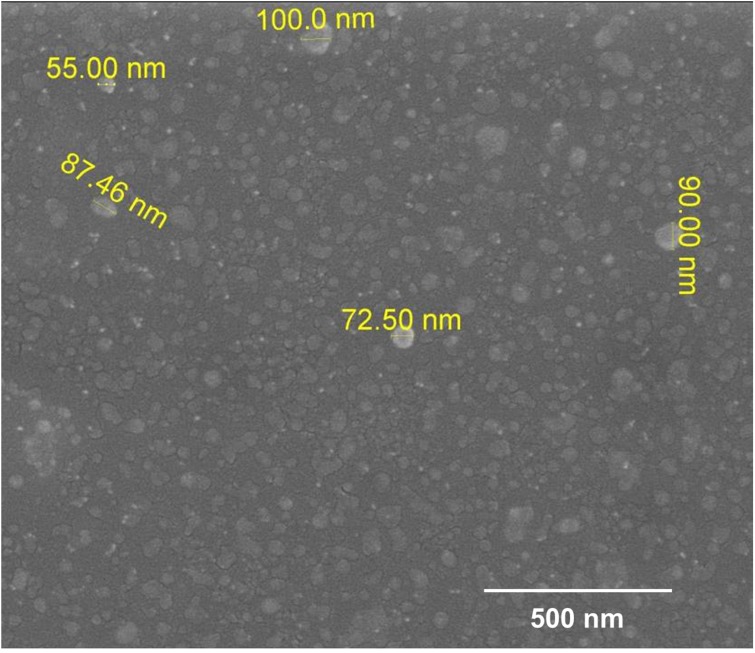
Scanning electron microscopy image of biosynthesized AgNPs.